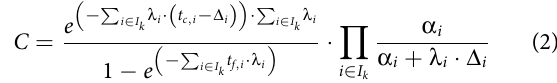
Frontiers in Built Environment |